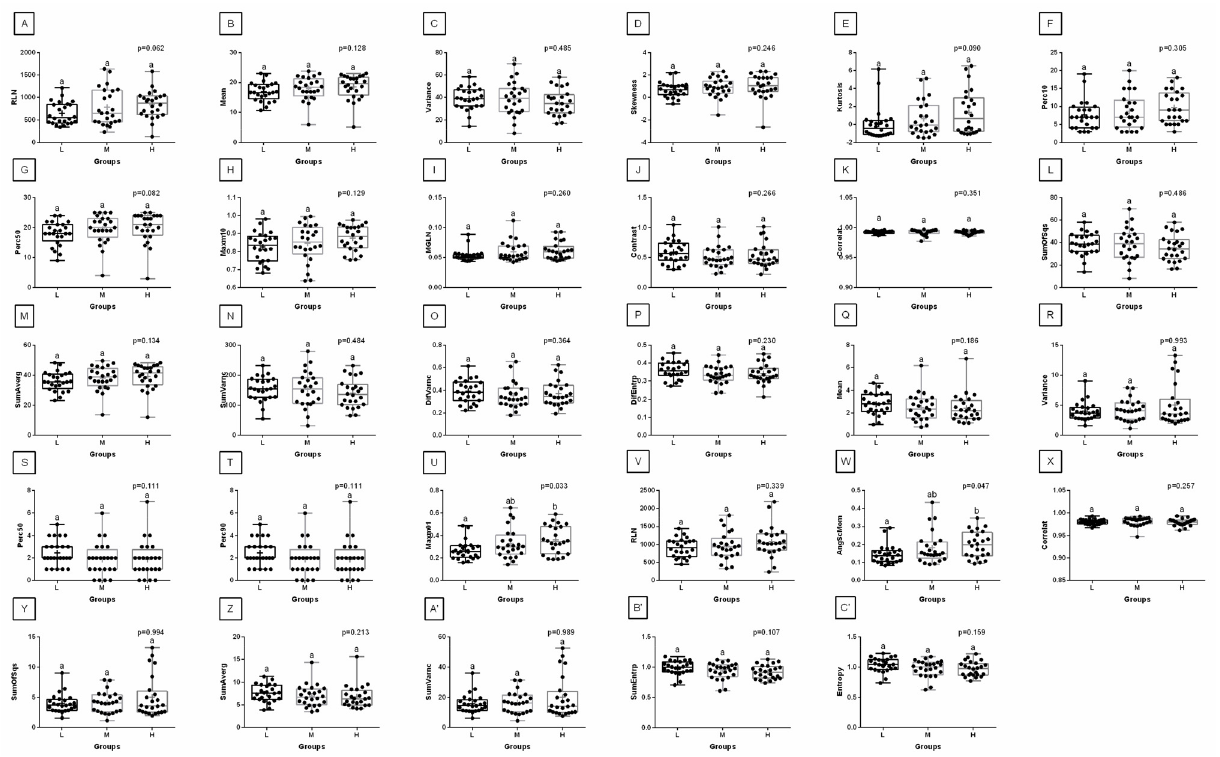
Figure 8. Analysis of texture features for the red, green, and blue components compared between light (L), moderate (M), and heavy (H) groups in the second region of interest (ROI 2). Differences between groups were indicated with individual p -values when p < 0.05. Different superscripts on